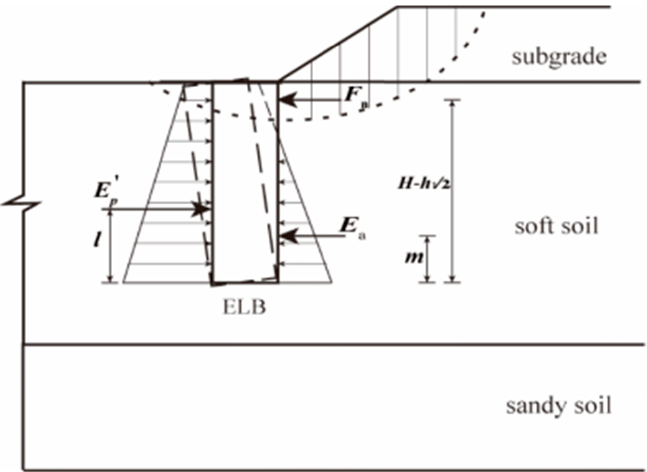
Figure 5. Diagram of the ELB overturn failure.